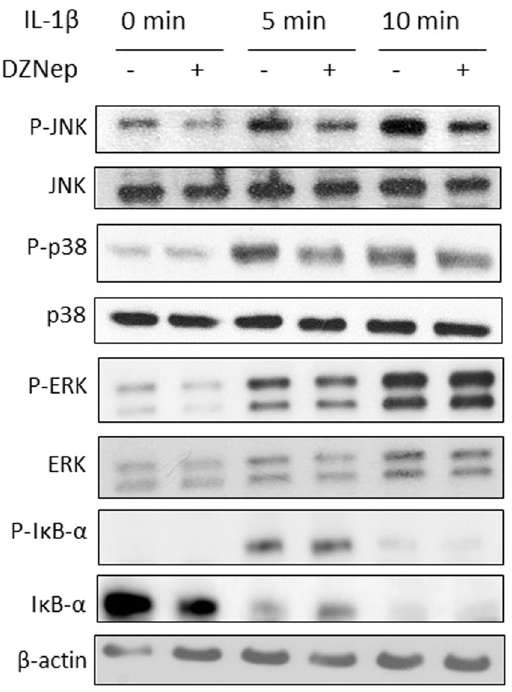
Figure 4. DZNep reduced MAPK pathway activation by IL-1 β . Primary chondrocytes were treated or not with DZNep (1 µ M) in the presence of IL-1 β (1 ng/mL) for 0 min, 5 min or 10 min. After treatment, proteins were extracted, and levels of P-JNK and JNK, P-p38 and p38, P-ERK and ERK, P-I κ B- α and I κ B- α were determined in cells by western blotting.